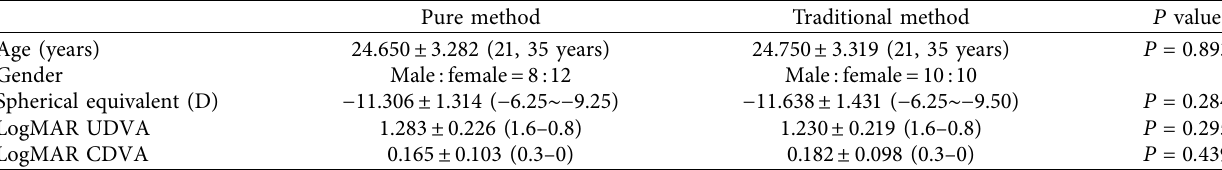
Table 1: Preoperative demographics of the eyes undergoing the pure ICL implantation and traditional ICL implantation.